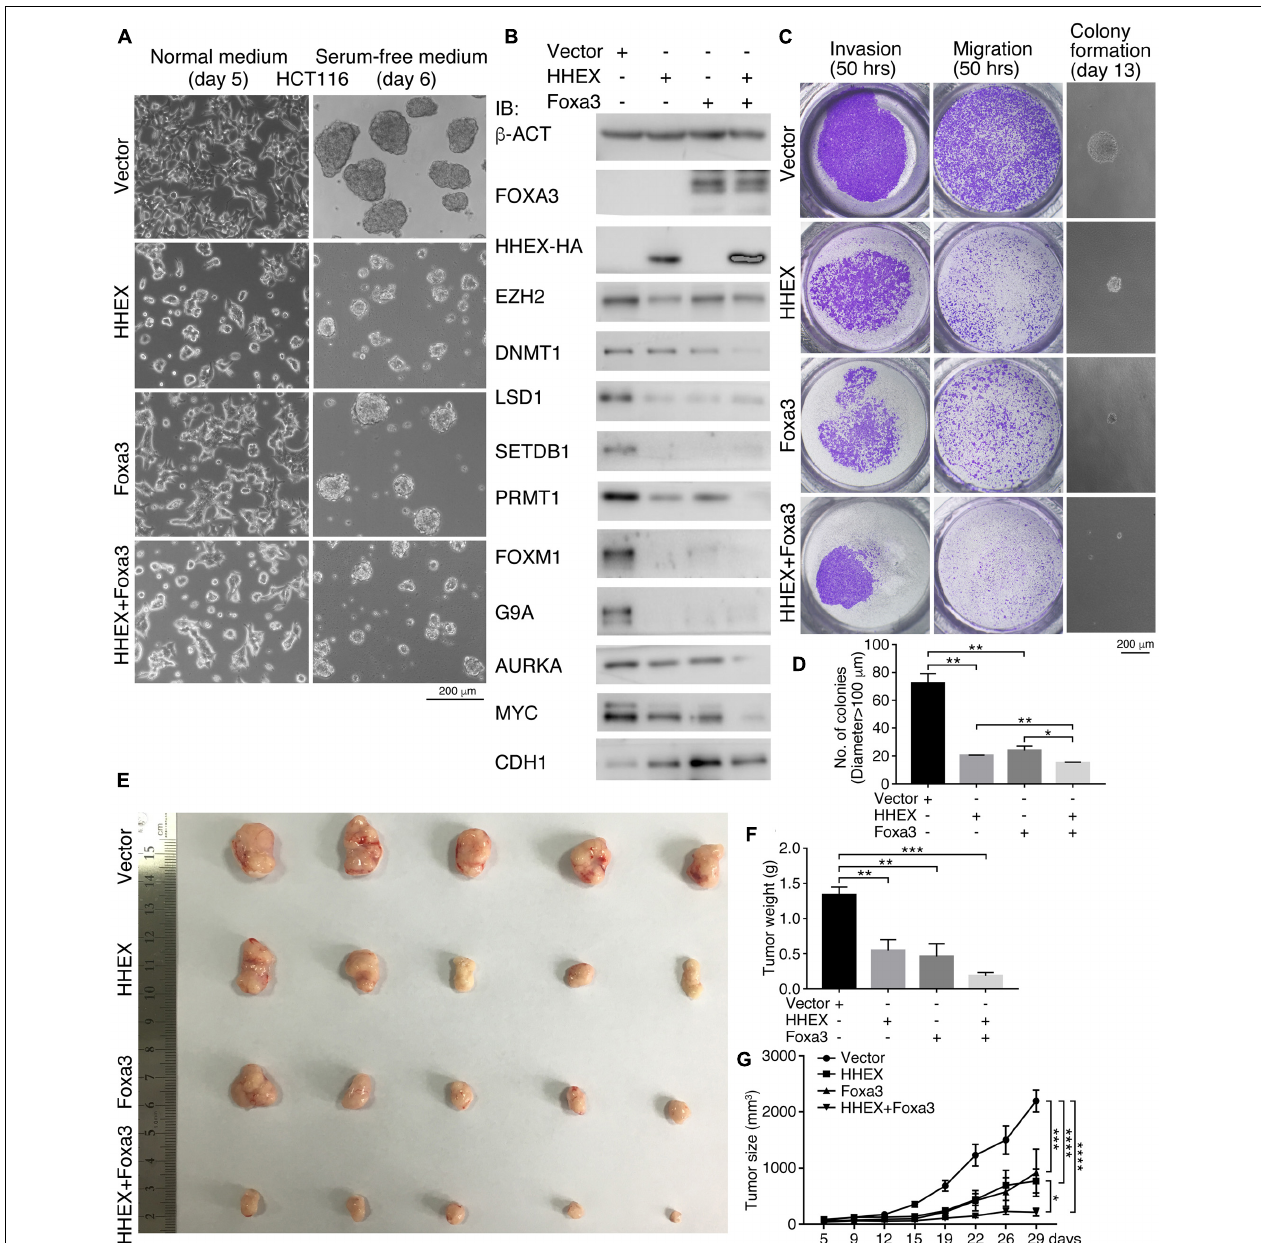
FIGURE 3 | HHEX, Foxa3, or their combination suppresses neural stemness and tumorigenicity in HCT116 cells. (A) Morphological alteration in HCT116 cells in normal culture medium and change in ability of neurosphere-like formation in NSC-specific serum-free medium in response to enforced expression of HHEX, Foxa3, or their combination. (B) IB detection of protein expression alteration in response to enforced expression of HHEX, Foxa3, and their combination. (C,D) Effect of expression HHEX, Foxa3, or their combination on invasion, migration, and colony formation in soft agar (C) . Significance in difference of colony formation was calculated based on experiments in triplicate using unpaired Student’s t -test (D) . Colonies larger than 100 µ m in diameter were counted. Data are shown as mean ± SEM. * p < 0.05 and ** p < 0.01. (E–G) Xenograft tumor formation (E) by control HCT116 cells (Vector) and cells with enforced expression of HHEX, Foxa3, and both. Significance of difference in tumor weight between two groups of mice was calculated using unpaired Student’s t -test (F) , and significance of difference in tumor volume was calculated using two-way ANOVA-Bonferroni/Dunn test (G) . Data are shown as mean ± SEM. * p < 0.05, ** p < 0.01, *** p < 0.001, and **** p <